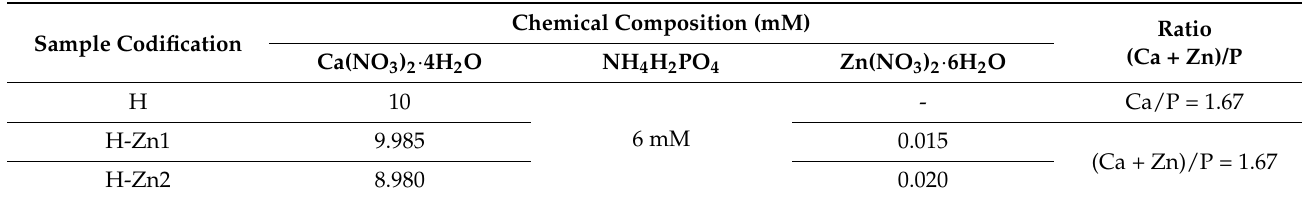
Table 1. Sample codification and chemical composition of the electrolyte used for the undoped and Zn doped